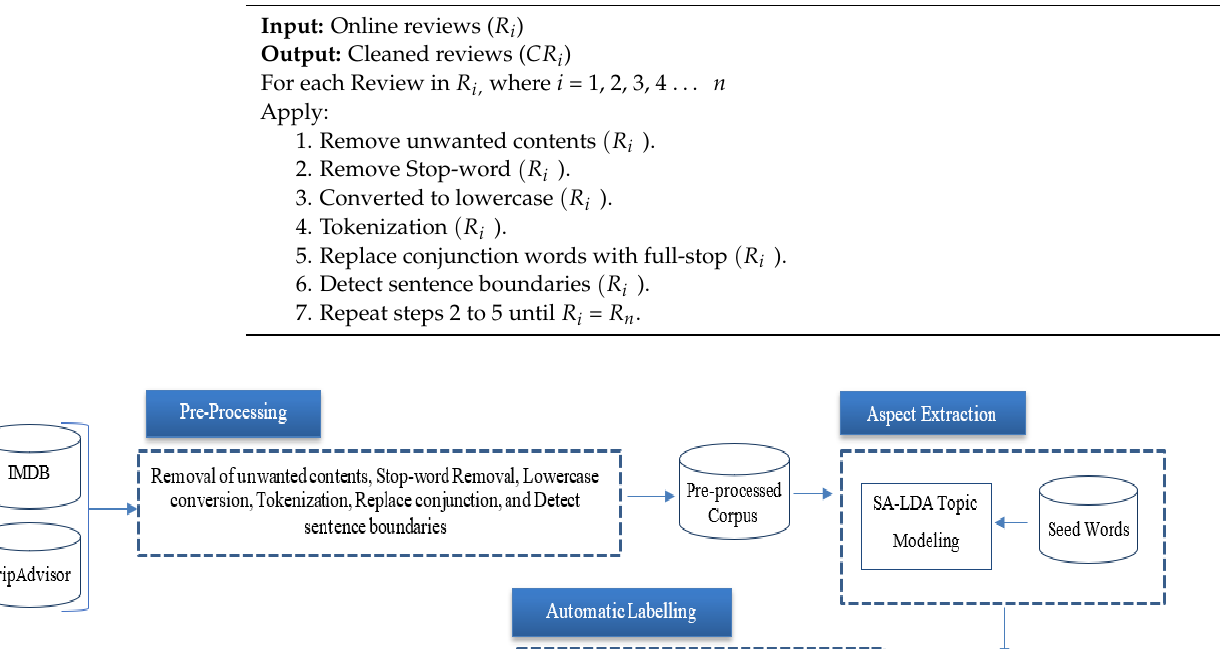
Algorithm 1: Algorithm for data collection and pre-processing